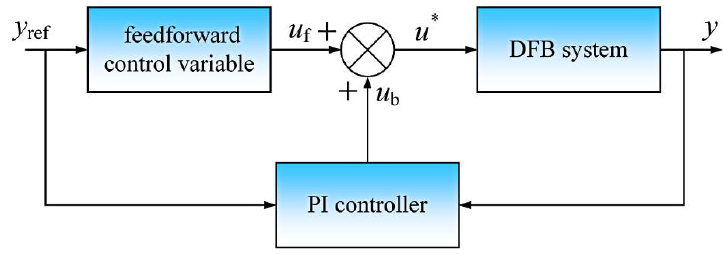
Figure 1. Structural diagram of a differential flatness-based (DFB) control system.